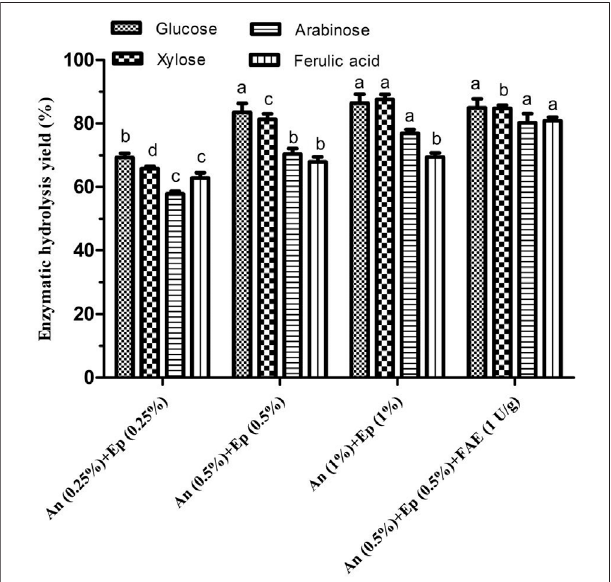
FIGURE 3 | Effects of different blended enzyme dosages on the enzymatic hydrolysisof wheat bran autohydrolysis residue. Ep, crude enzyme from E. parvum ; An, crude enzyme from A. niger ; FAE, ferulic acid esterase. Enzymatic hydrolysis yield of the same product between different treatments were conducted for one way analysis of variance (ANOVA) and multiple comparisons, where different lowercase letters indicate signi fi cant difference at p < 0.05 probability